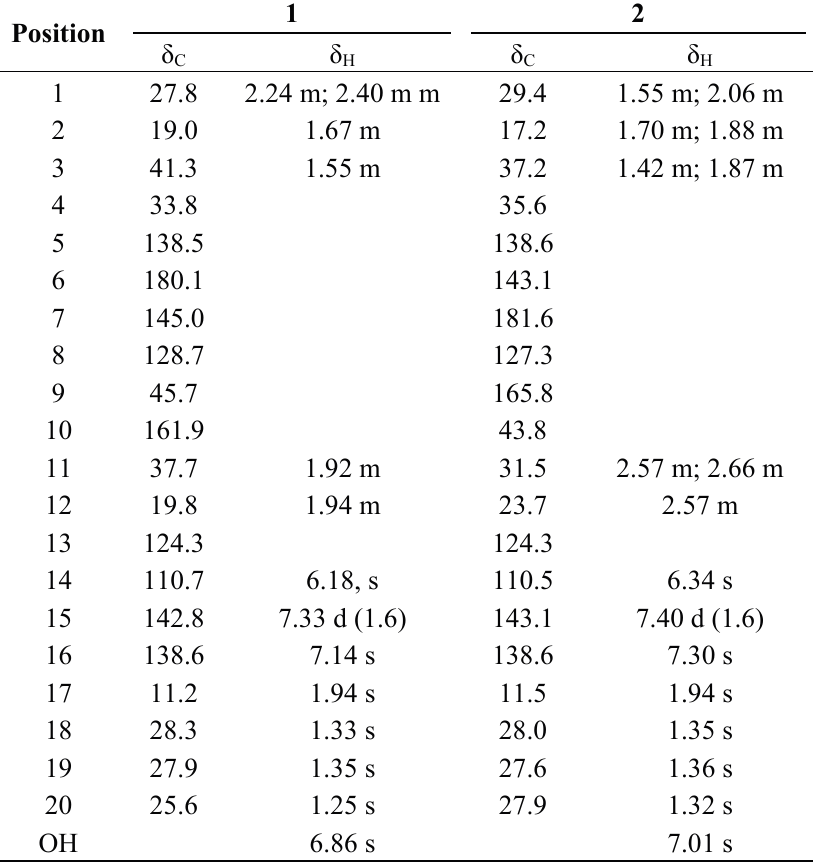
Table 1. 1 H-NMR and 13 C-NMR data of 1 and 2 (400 and 100 MHz; CDCl 3 , δ ppm, J in